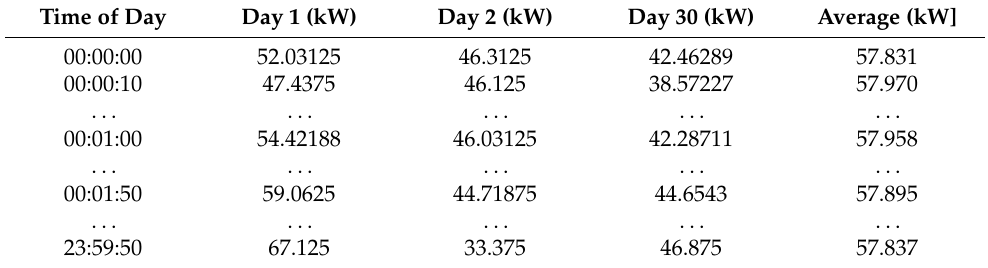
Table A2. Averaging procedure.